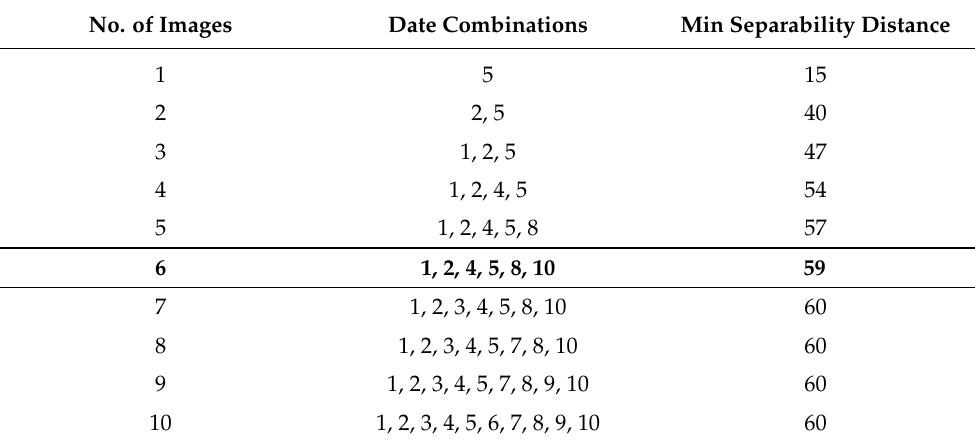
Table 4. Separability analysis using CBSI-MSAVI2 temporal indices images for the selection of best temporal dates to map Pigeon Pea crop with spectrally least similar cotton